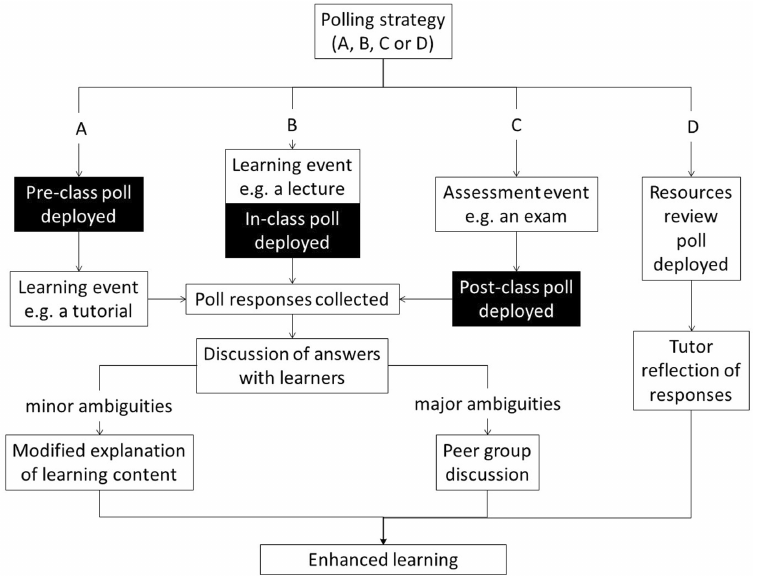
Figure 1. Polling